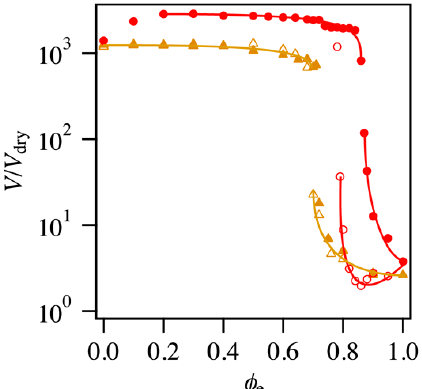
Figure 5. The degree of swelling V / V dry of sulfonated SR gels in the higher ionization region as a function of ethanol volume fraction φ e in the ethanol-water mixture. The average numbers of sulfo groups per CD were found to be 2.8 (triangle) and 3.4 (circle). Filled and open symbols denote the shrinking and swelling processes, respectively. Solid lines are eye guides.